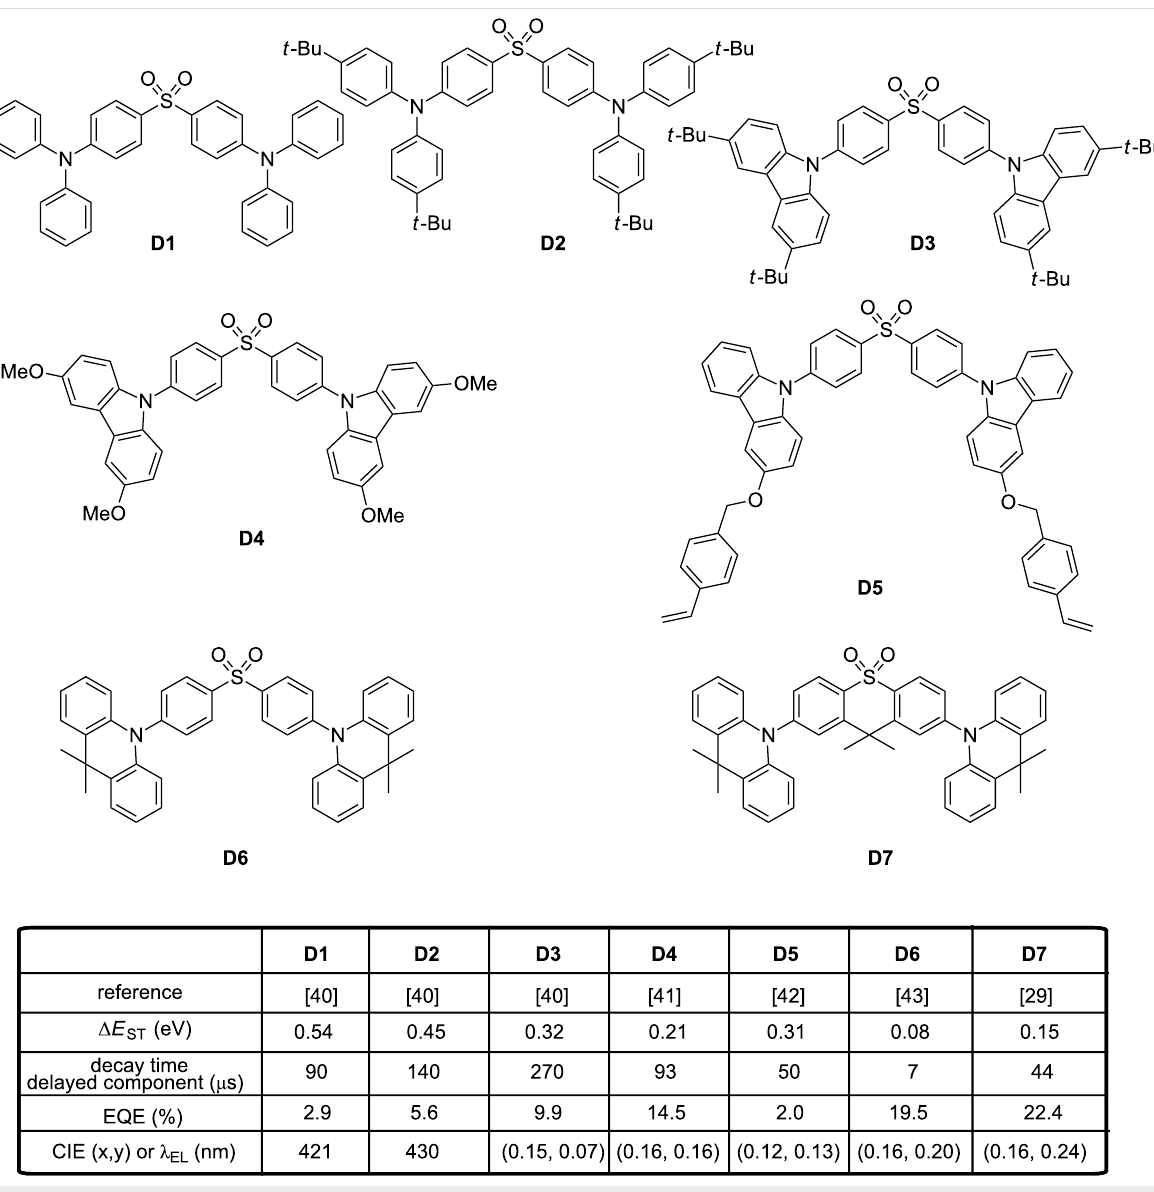
Figure 3: Diphenylsulfone-based TADF emitters D1 – D7